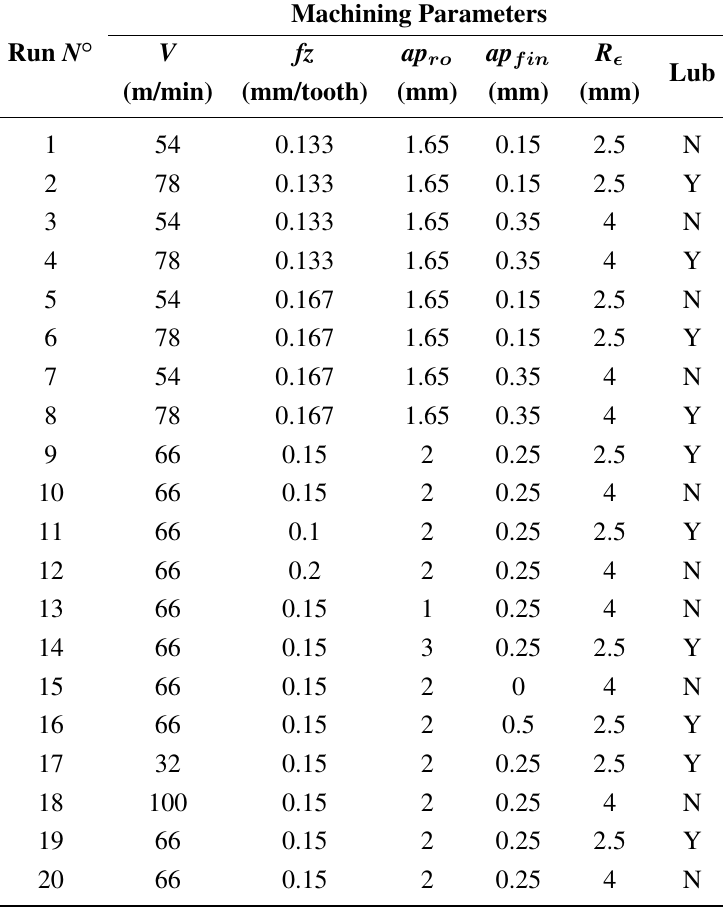
Table 2. Experimental design.